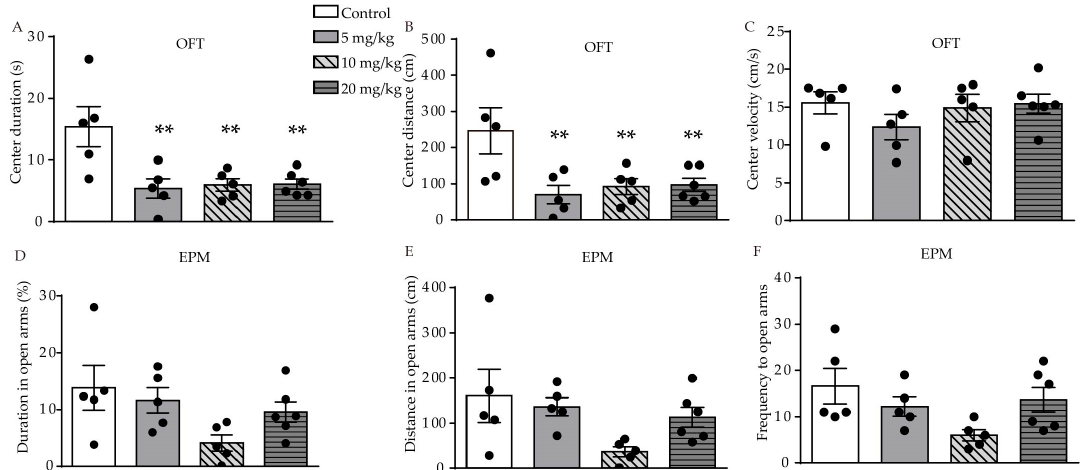
Figure 1. E ff ects of di ff erent doses of ATRA on anxiety-like behavior in mice. ( A – C ) center duration, distance and velocity in OFT in ATRA treatment and control groups; ( D – F ) duration, distance and frequency in open arms in EPM test. Data are expressed as mean ± SEM, with n = 5–6 in each group. ** p < 0.01 versus controls, using one way ANOVAs with least significant difference (LSD) test. Results of the FST showed a difference was found among the four groups (F (3, 17) = 4.555, p = 0.0162, Figure 2A). The result showed that only mice who were administered a dose of 10 mg/kg